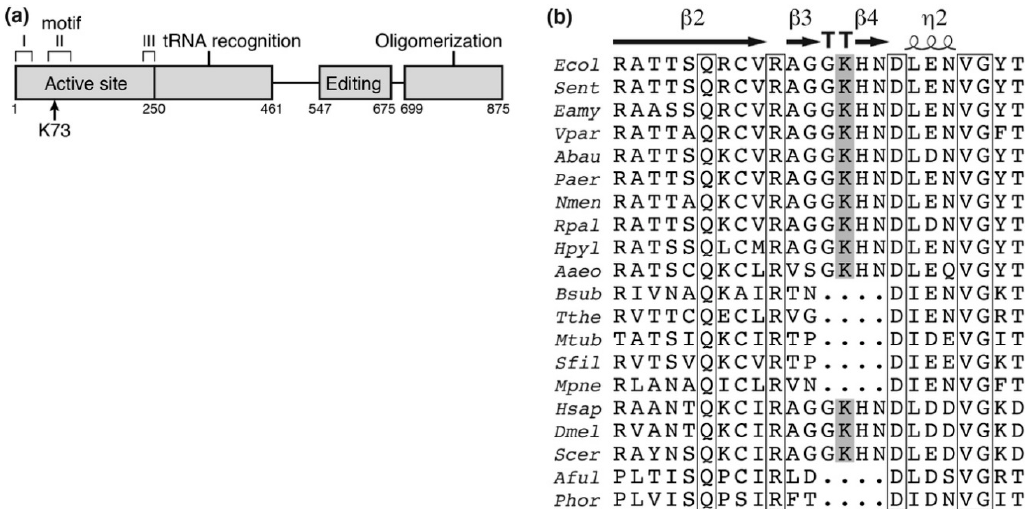
Figure 1. Schematic position of lysine-73 (K73) acetylation site in alanyl-tRNA synthetase (AlaRS). ( a ) Schematic representation of AlaRS with functional domains. K73 is located within the motif II, an essential constituent for the active site. ( b ) The alignment of sequences surrounding K73 in AlaRS.